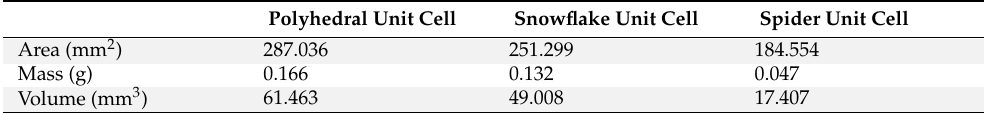
Table 2. Unit cells